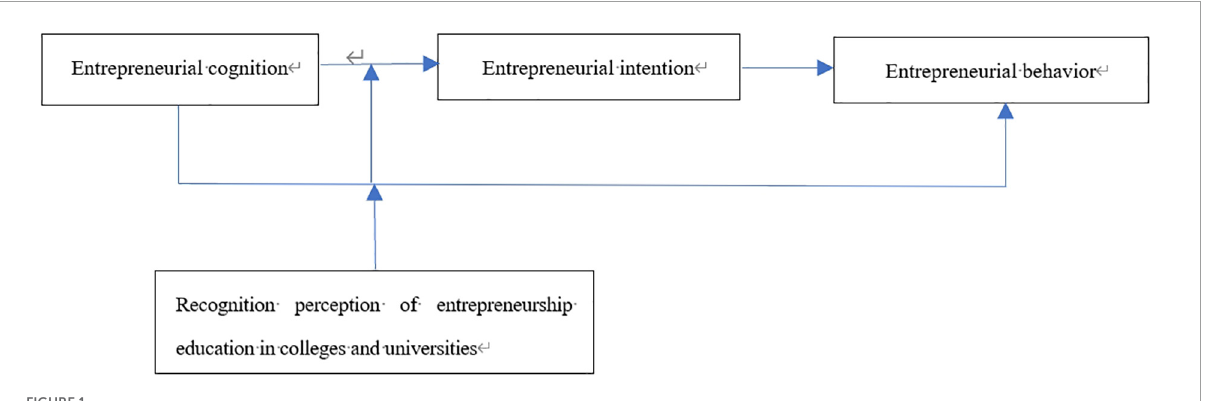
FIGURE1 Theoretical framework of present